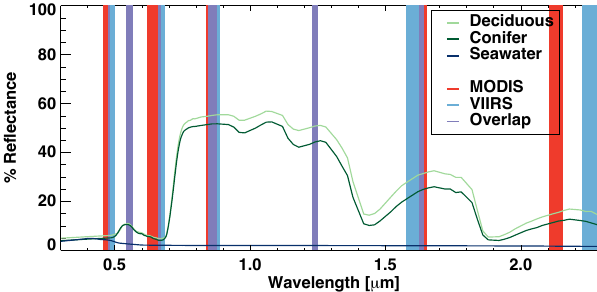
Figure 5. Bandwidths for MODIS (red) and VIIRS (blue) channel bands to be used for a the MODIS-like DT aerosol retrieval, over- plotted with vegetation and seawater spectra. The two vegetation (“deciduous”, “conifer”) spectra are from JPL’s ASTER spectral library (http://speclib.jpl.nasa.gov/), while the “seawater” is from